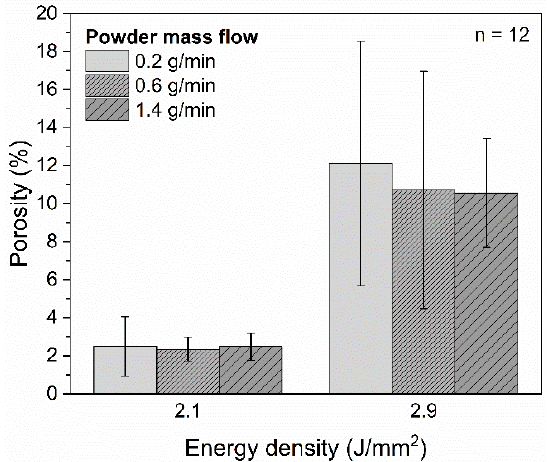
Figure 7. Porosity of the PA12 coatings as a function of on the energy density for powder mass flows of 0.2 g/min, 0.6 g/min and 1.4 g/min ( n = 12).